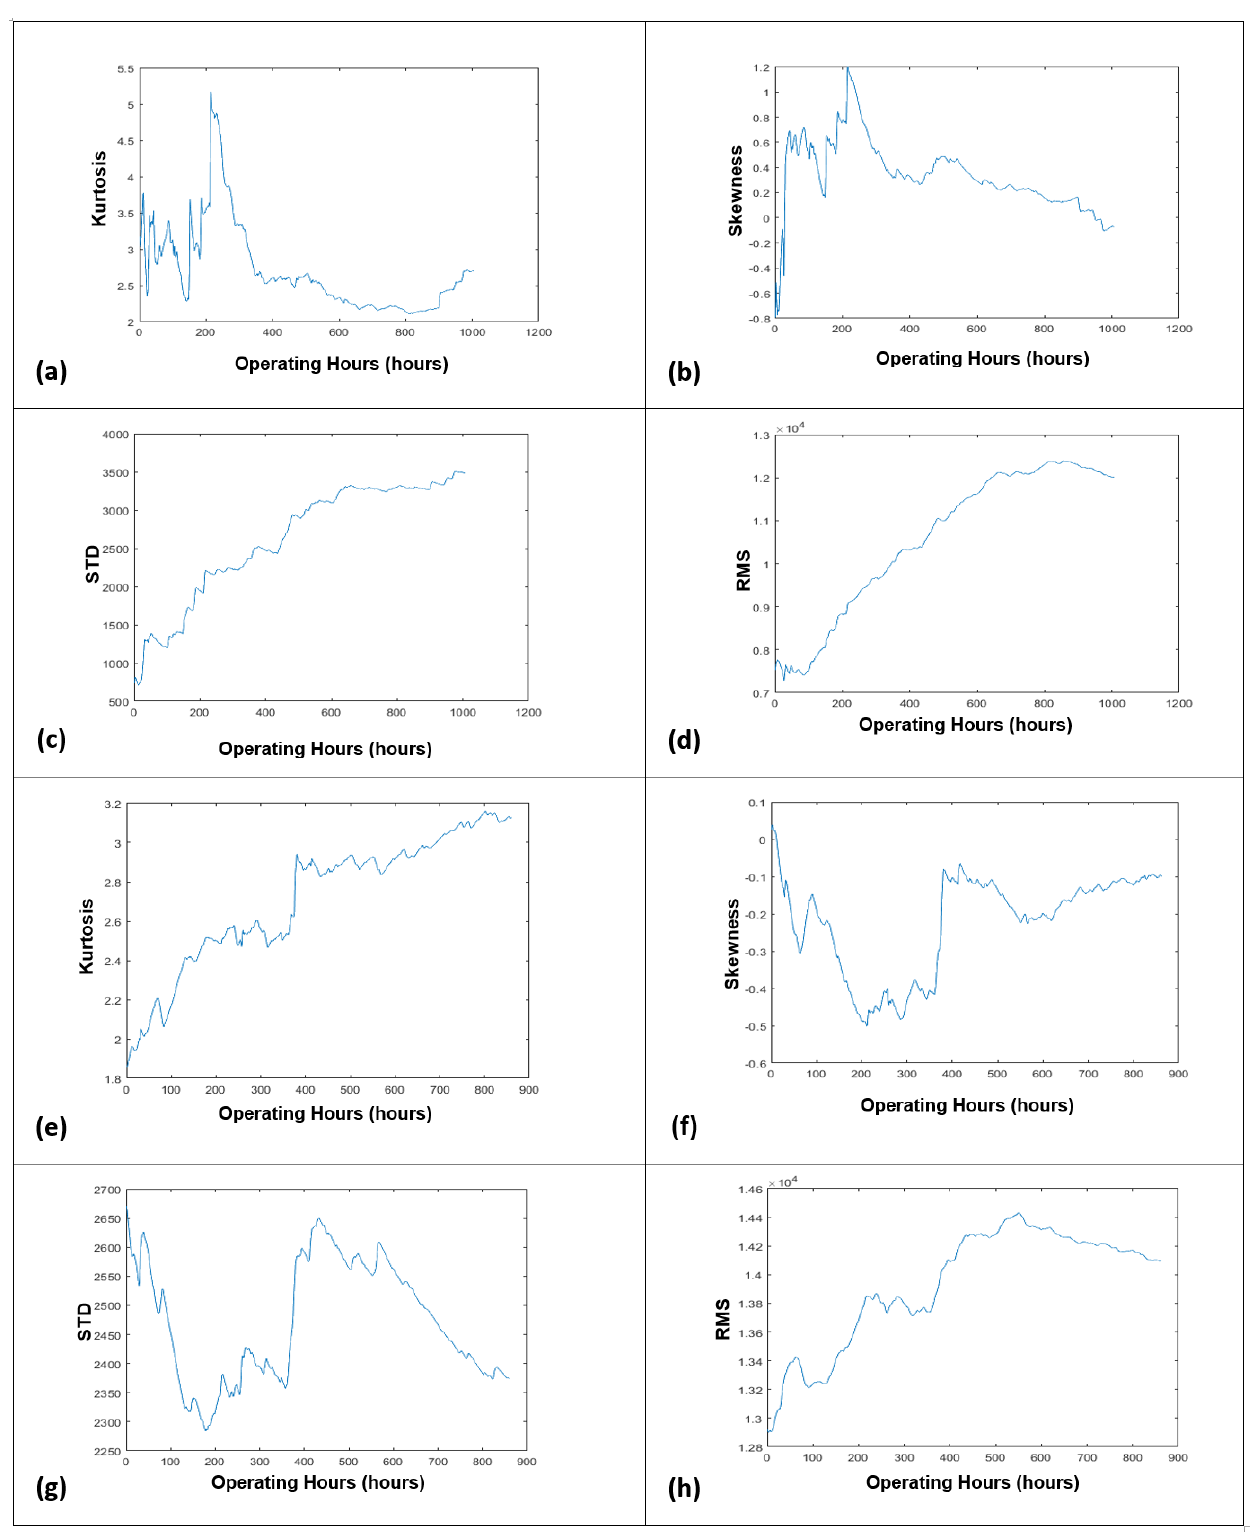
Figure 4. Degradation trends generated by kurtosis, skewness, St. deviation, and RMS using dataset 2014 ( a – d ), and dataset 2017 ( e – h ).